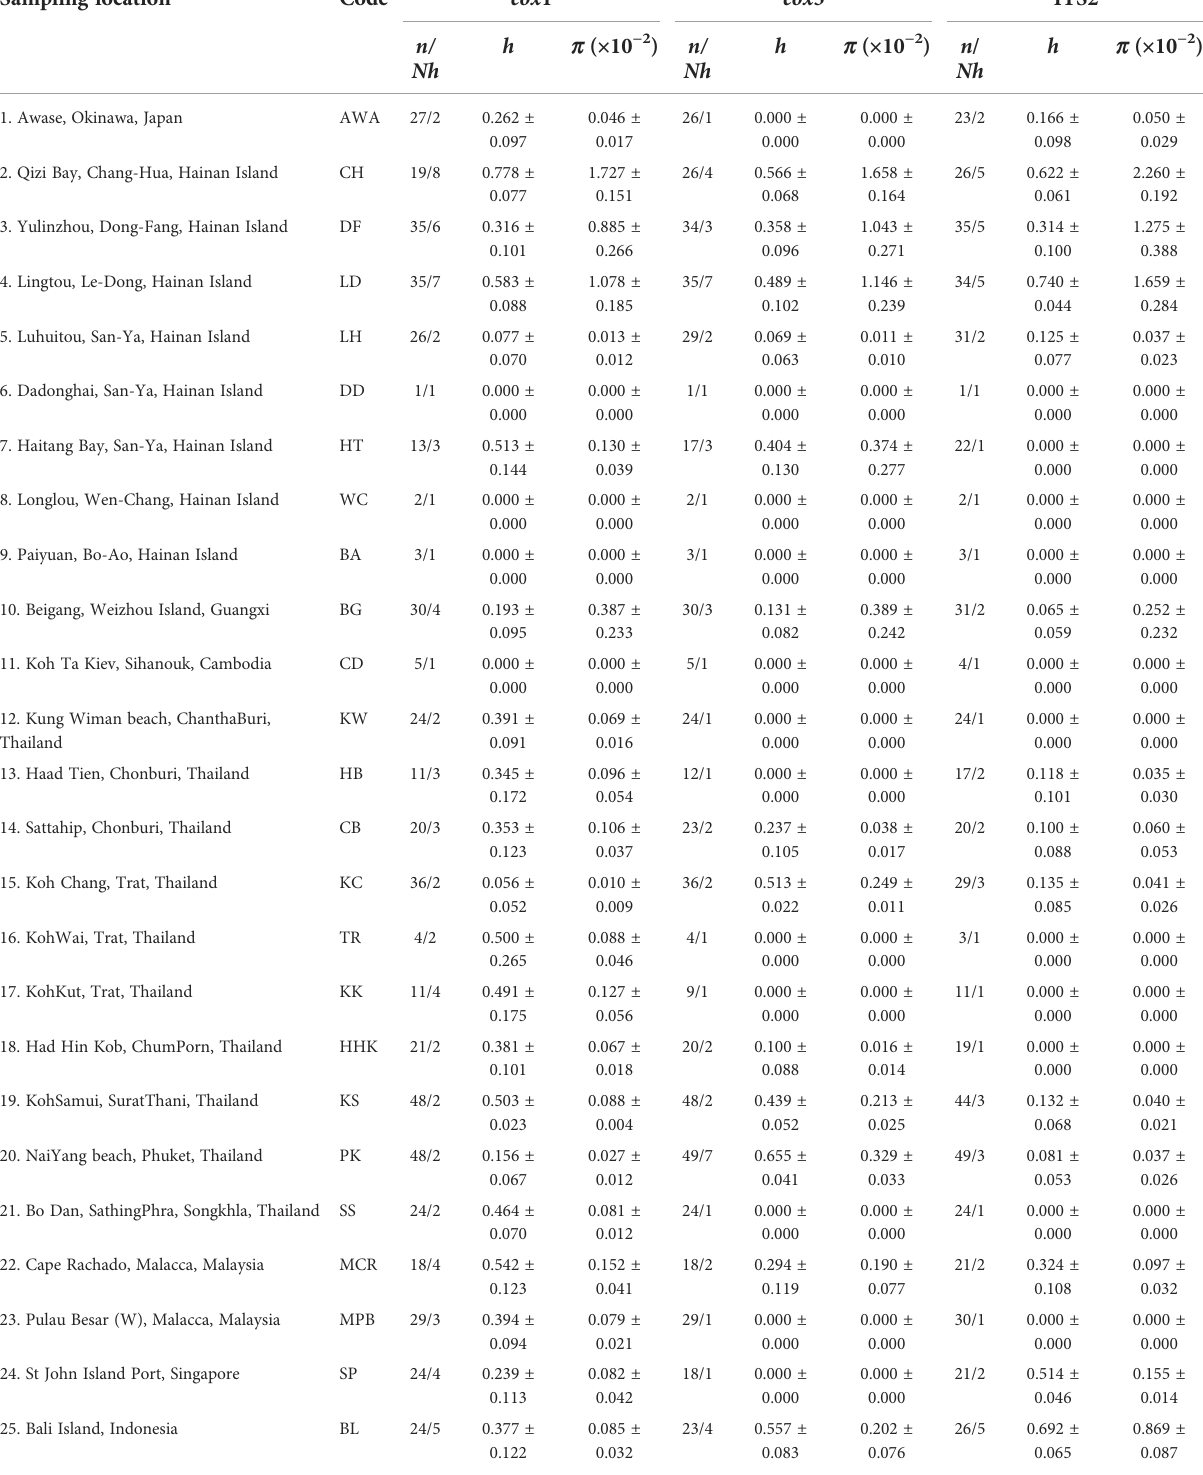
TABLE 1 Genetic diversity indices of Sargassum polycystum populations inferred from mitochondrial cox 1, cox 3 and nuclear ITS2. Sampling